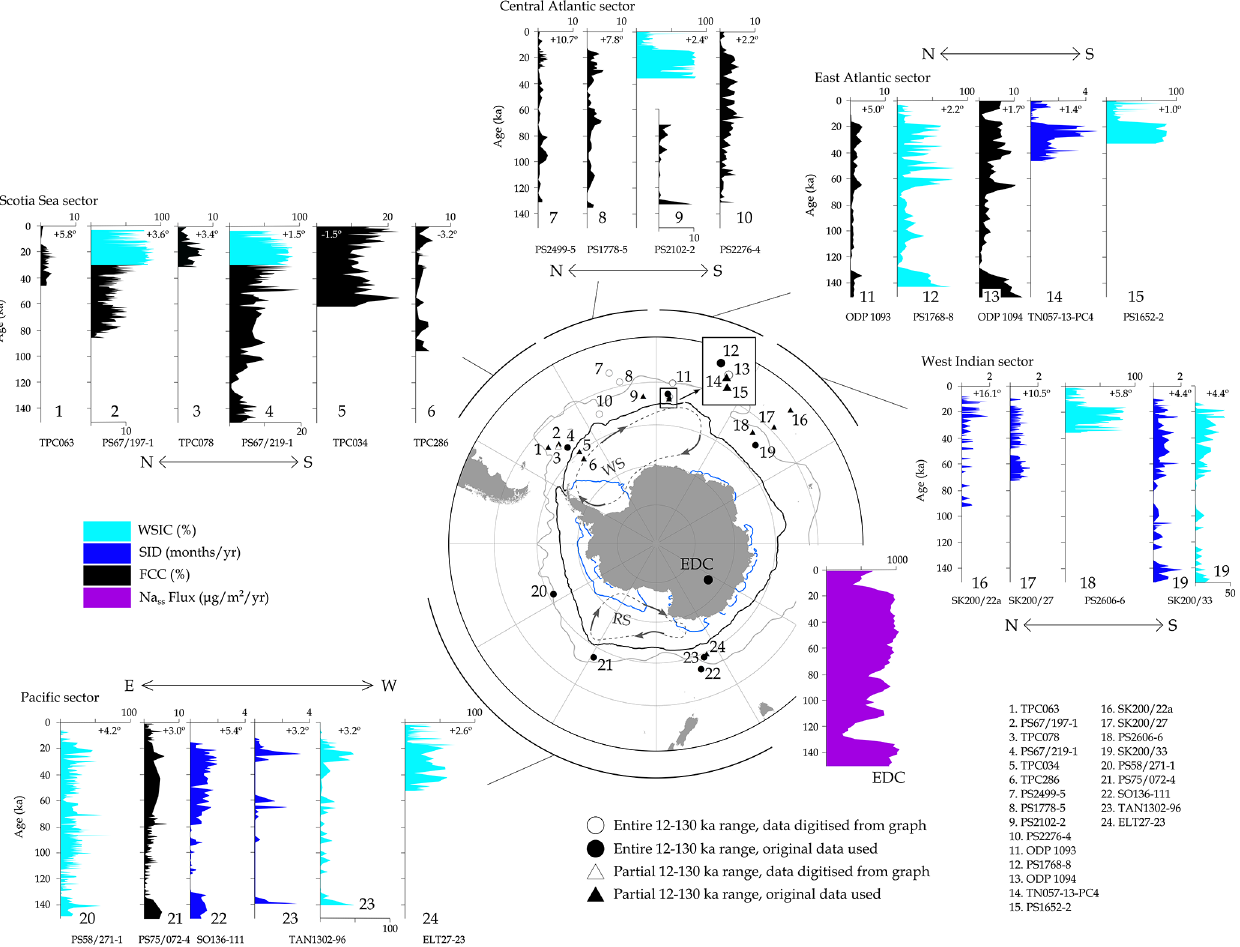
Figure 1. FCC (combined relative abundance of F. curta and F. cylindrus ), WSIC (winter sea-ice concentration) and SID (sea-ice duration) records from Southern Ocean marine sediment cores and the Na ss flux record from the EDC ice core shown alongside a map of Antarctica with core locations, modern February (blue line) and September (black line) sea-ice extents (data from Fetterer et al., 2017) and the modern Antarctic Polar Front position (grey line; Trathan et al., 2000). Dashed lines mark the modern extents of the Weddell Sea (WS) and Ross Sea (RS) gyres. Downcore records are arranged together in Southern Ocean regions, with distance from the modern winter sea-ice (WSI) edge given in degrees latitude (plus sign indicates locations north of the mean WSI edge, minus sign indicates locations south of the mean WSI